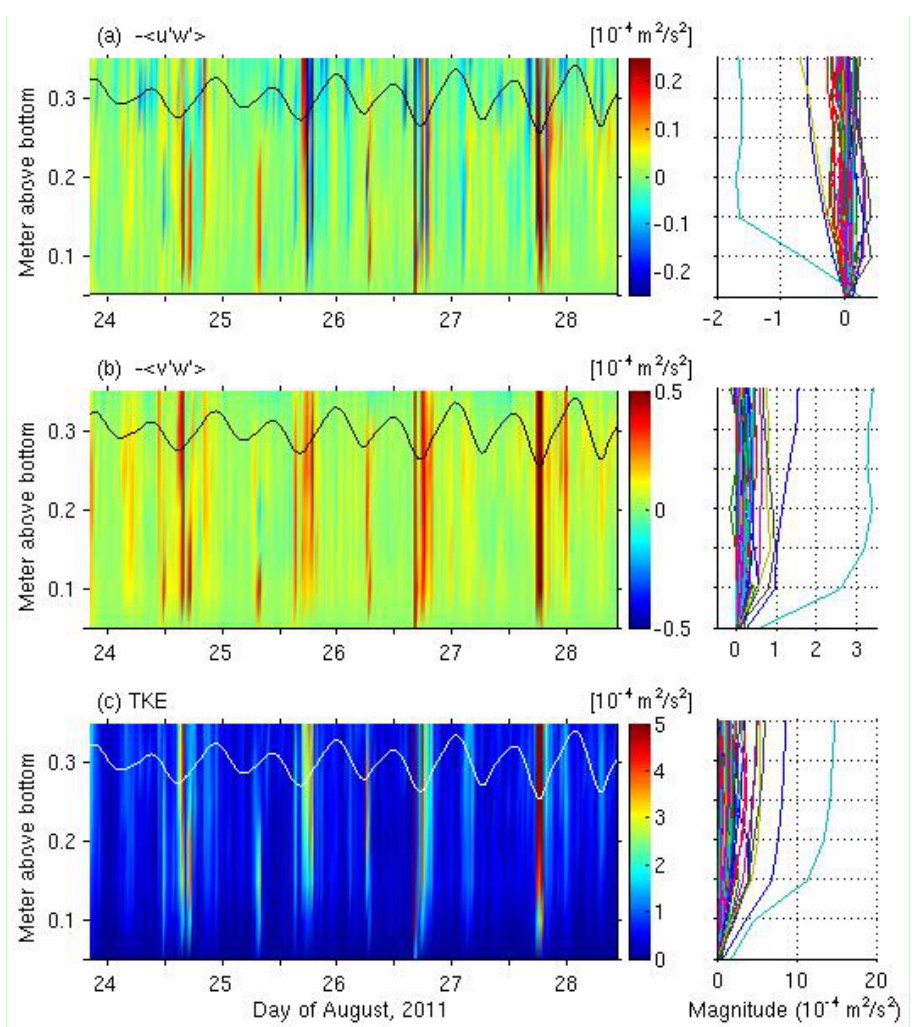
Figure 5. Reynolds stress and turbulent kinetic energy profiles near bed: ( a ) east–west component, ( b ) north–south component, and ( c ) turbulent kinetic energy (TKE). Black and white solid lines in the left panel indicate the sea level variation.